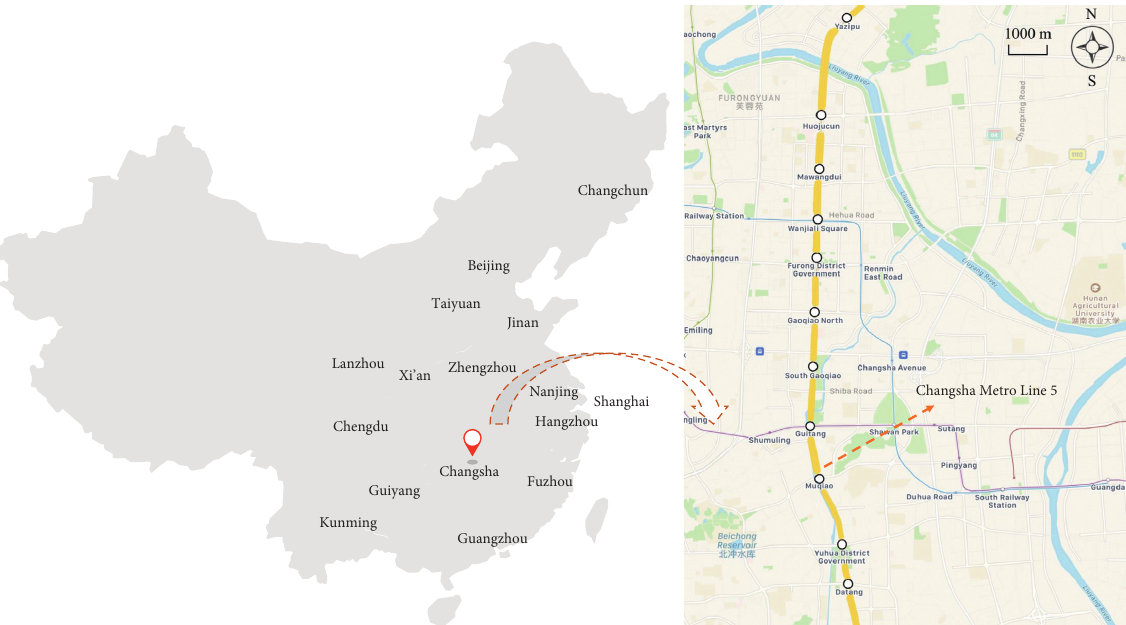
Figure 1: The location of Changsha Metro Line